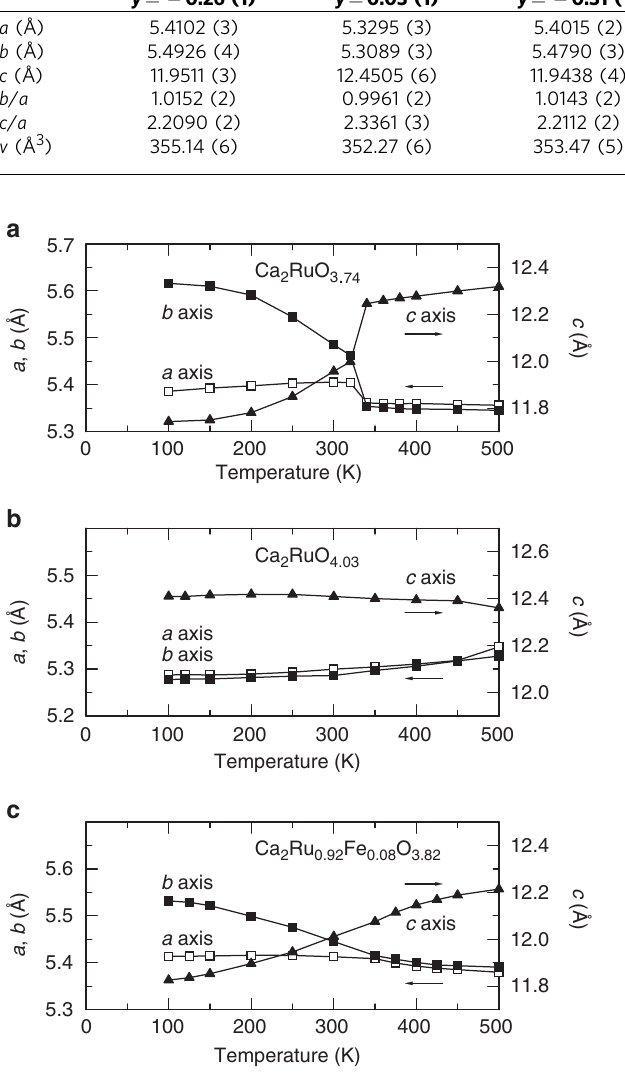
Figure 3 | Temperature dependence of the lattice parameters. ( a ) Ca 2 RuO 3.74 , ( b ) Ca 2 RuO 4.03 and ( c ) Ca 2 Ru 0.92 Fe 0.08 O 3.82 . These values are estimated based on Le Bail analysis of the XRD data. For Ca 2 RuO 3.74 ,